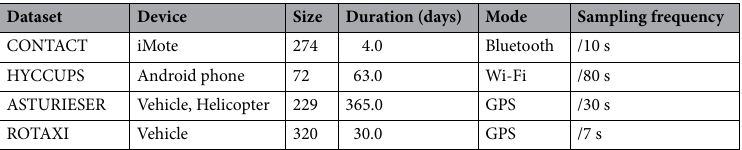
Table 3. Basic details of four datasets.